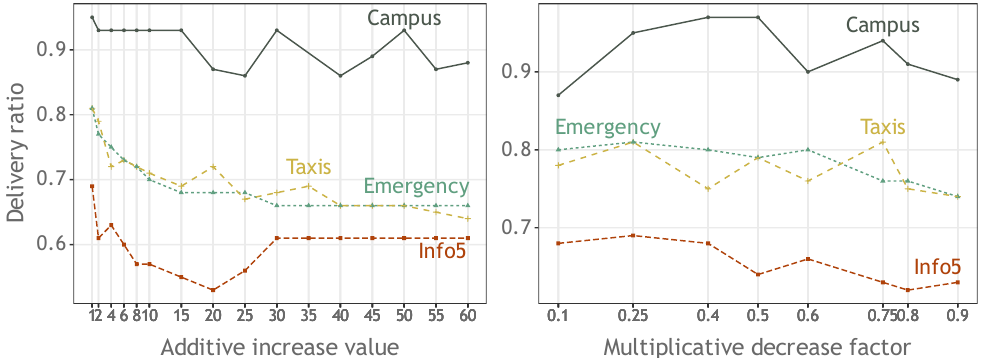
Figure 14. Delivery ratio vs. different values for the AIMD control